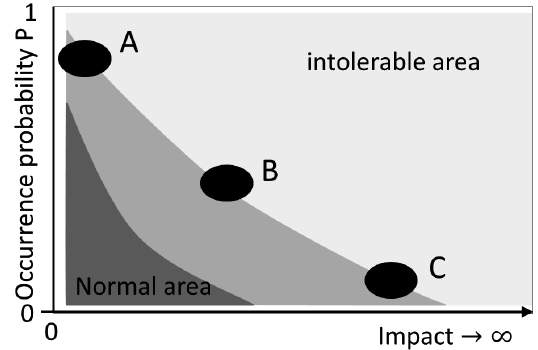
Fig. 9. Risks areas: normal, intermediate and intolerable. Adapted from Farmer (1967). Three cases are depicted. Risk event A: low impact/high probability of occurrence; Risk event B: intermediate case; Risk event C: high impact/low probability of occurrence cor- responding to a catastrophic